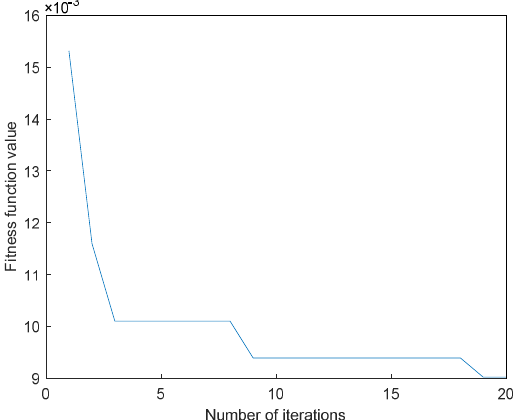
Figure 18. The fitness function varies with the number of iterations. It can be seen from Figure 18 that when the number of iterations reaches 19, the fitness function takes the minimum value 9 × 10 − 3 . After setting the parameters in MCKD according to the optimal parameter combination obtained, use MCKD to perform deconvolution analysis on the optimal components and obtain the analyzed time-domain waveform and envelope spectrum, as shown in Figure 19. From the time-domain waveform in Figure 19a, the shock component can be clearly observed. The spectral lines of the fault characteristic frequency and its multiples are clearly visible in the deconvoluted envelope spectrum, and the fault type of the fault signal can thus be identified as an inner-loop fault, indicating that the characteristic frequency is accurately extracted, thus verifying the effectiveness of the method proposed in this